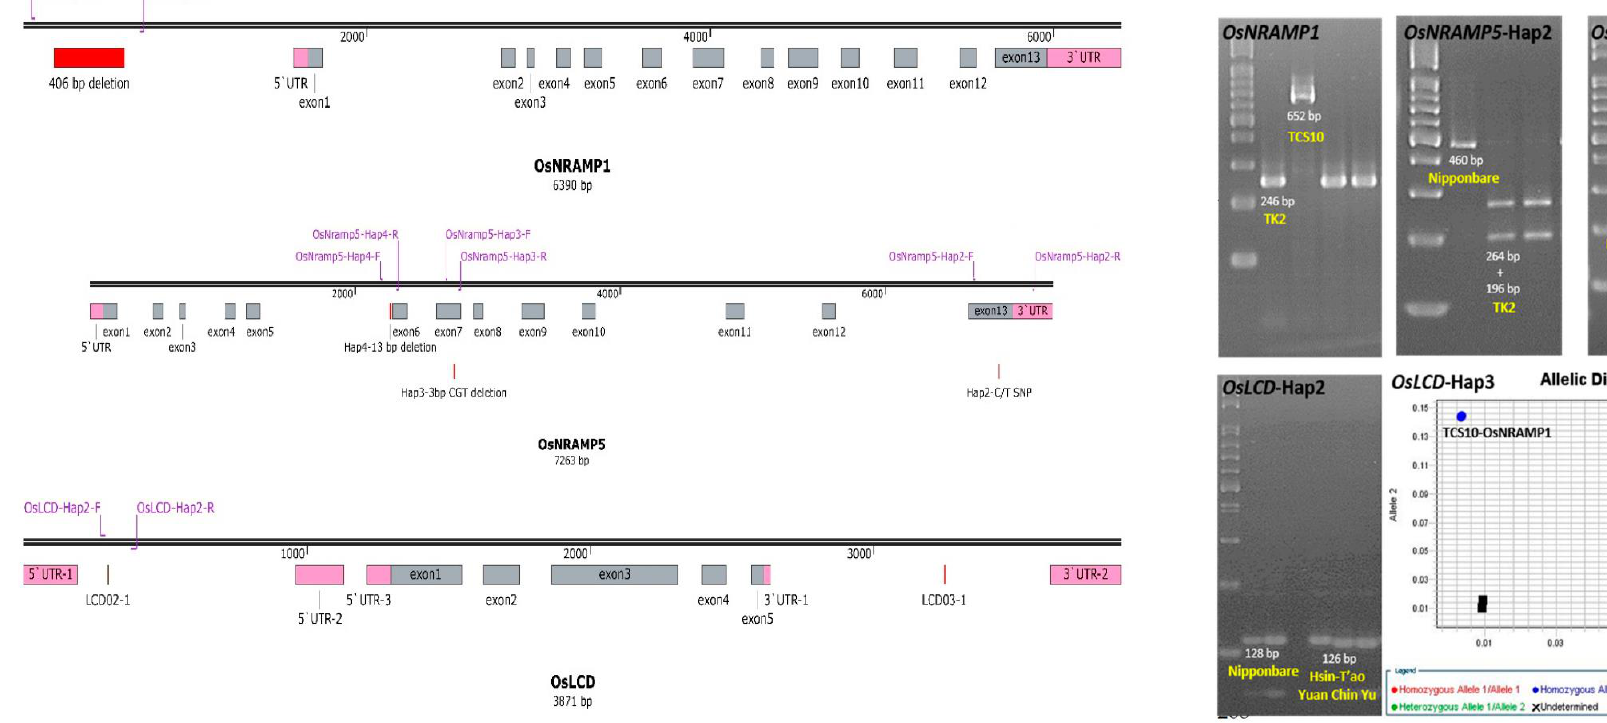
Figure 3. The gene structures, functional markers, and PCR results for haplotypes of OsNRAMP1 , OsNRAMP5 , and OsLCD.